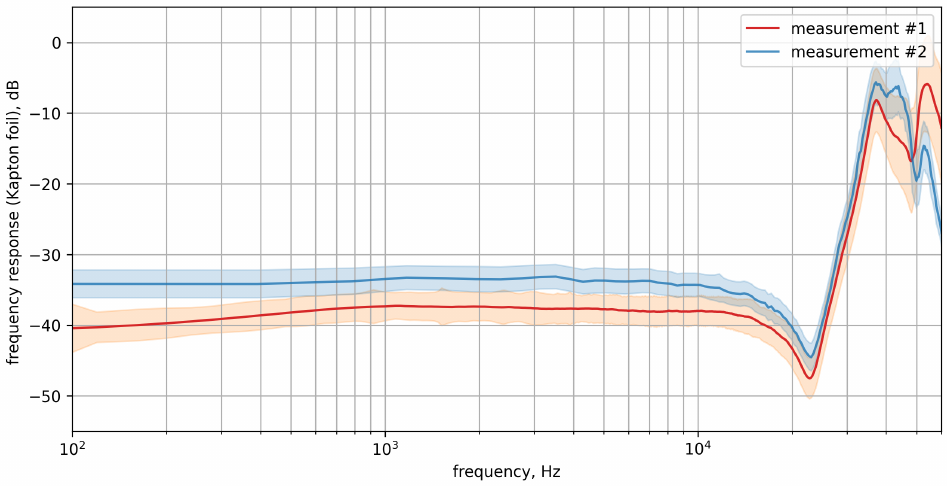
Figure 9. Mean frequency response of all array sensors treated with Kapton foil with standard deviation for two different applications of the coating with the Kapton foil (measurement #1: exact treatment as used in this paper). The respective standard deviation is depicted by the